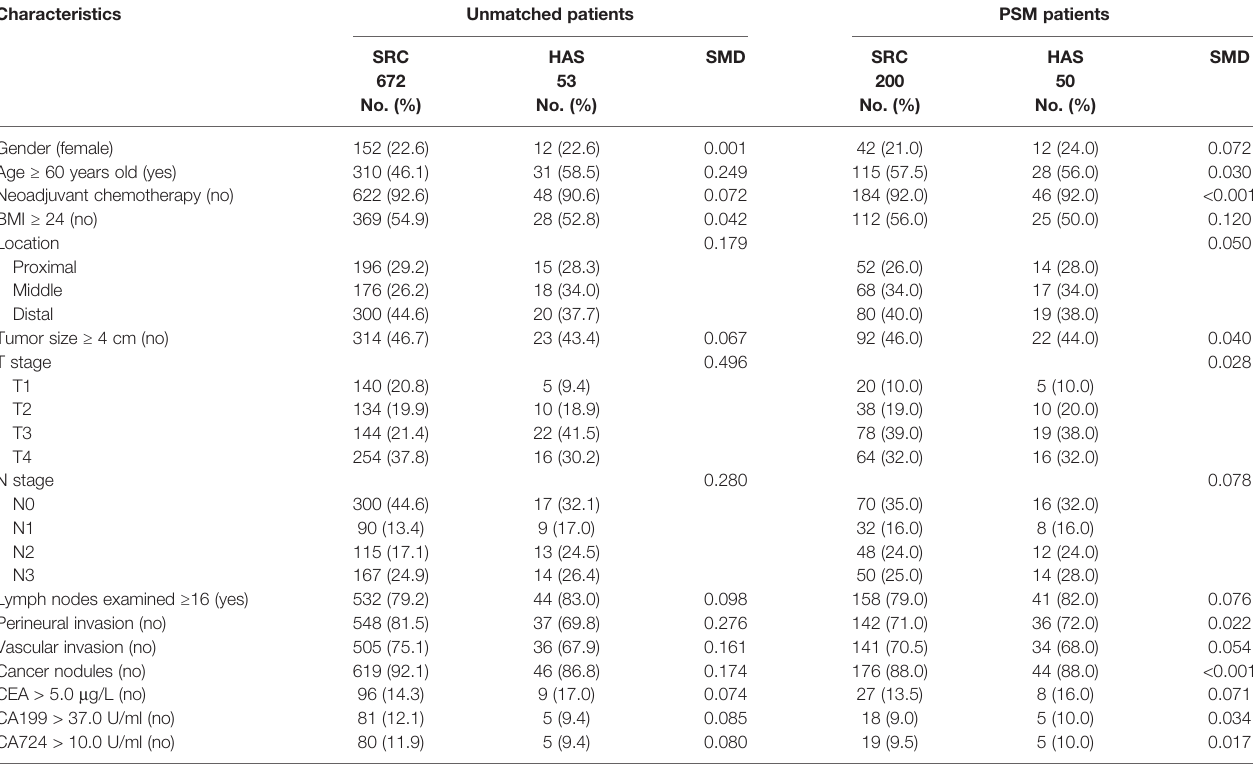
TABLE 1 | Baseline characteristics of